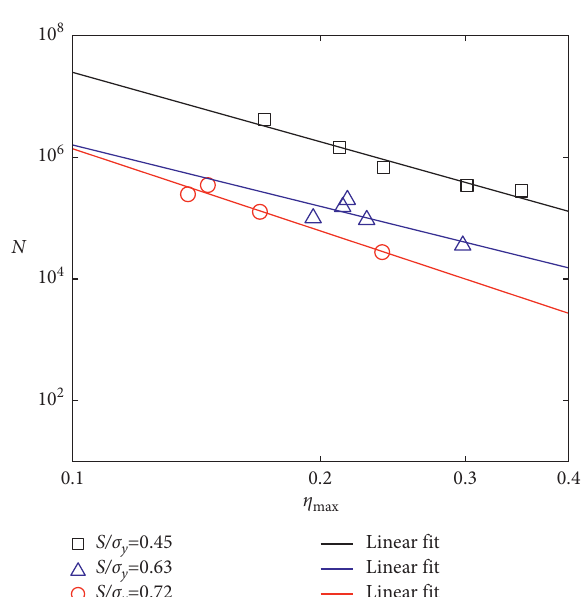
Figure 7: Relationship between fatigue life and MCD at three stress